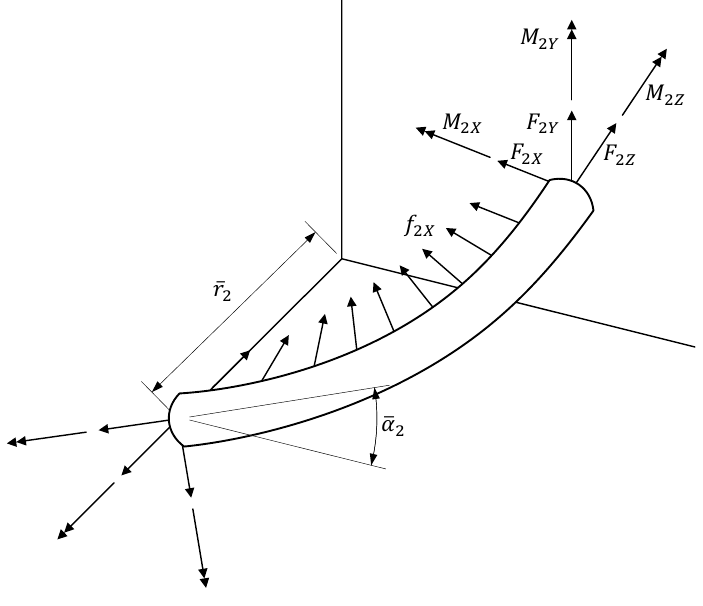
Figure 3. Loads acting on a helical wire.